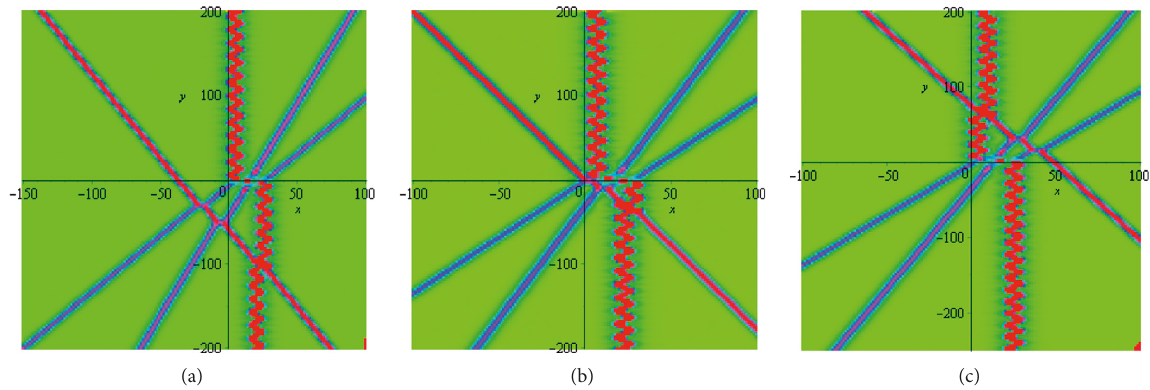
Figure 25: Plots of equation (86) by taking ϕ (c) f